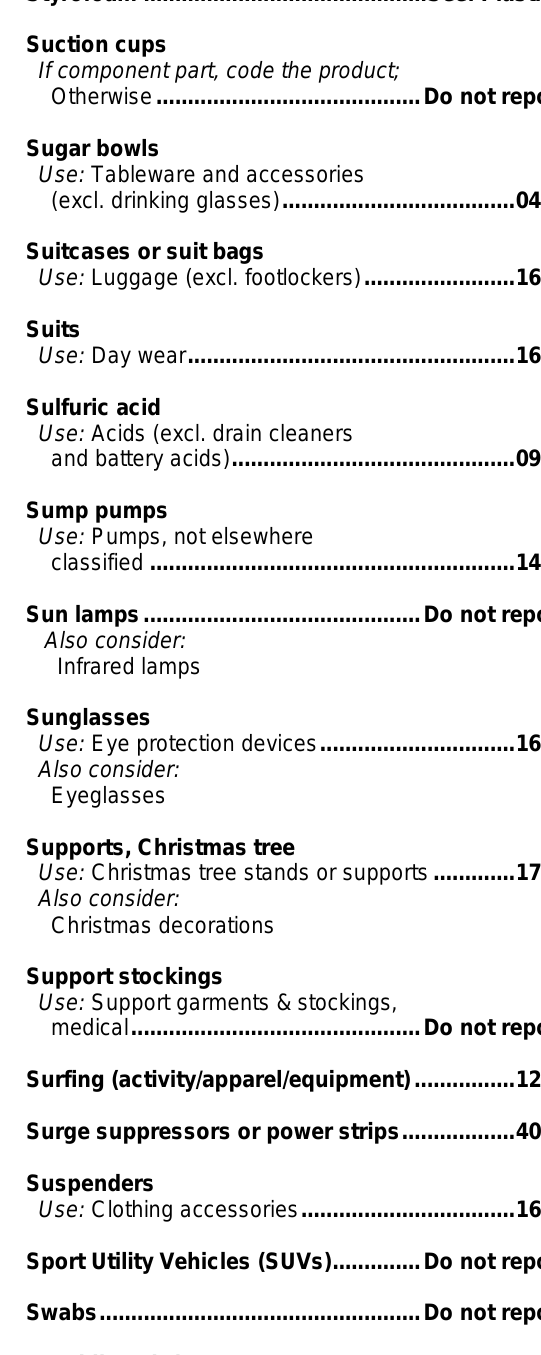
Sugar bowls Use: Tableware and